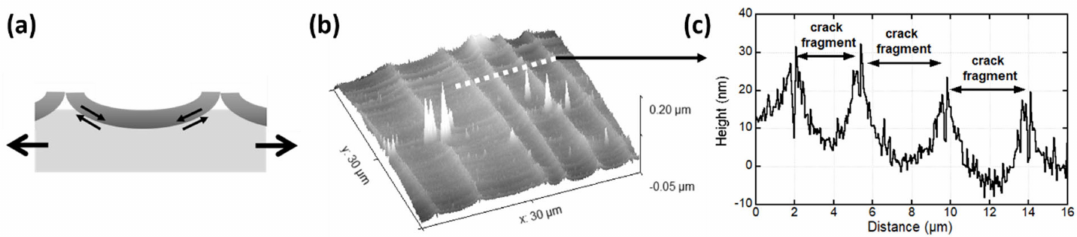
Figure 2. ( a ) Schematic diagram of fragments bending in cross-section, ( b ) 3D atomic force microscopy height image of crack fragments in a 200 nm sputter deposited Cr film on PI at 10% strain. White dashed line indicates the profile in ( c